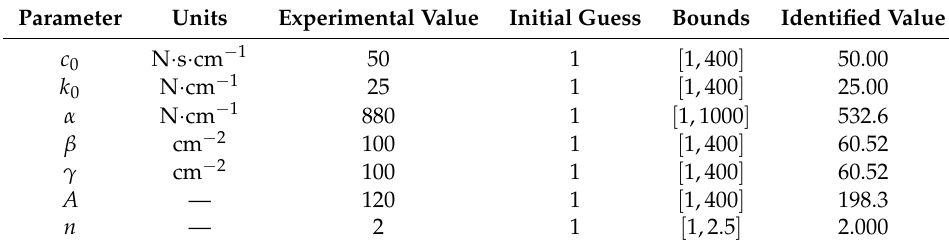
Table 8. Parameters in the magnetorheological damper system model